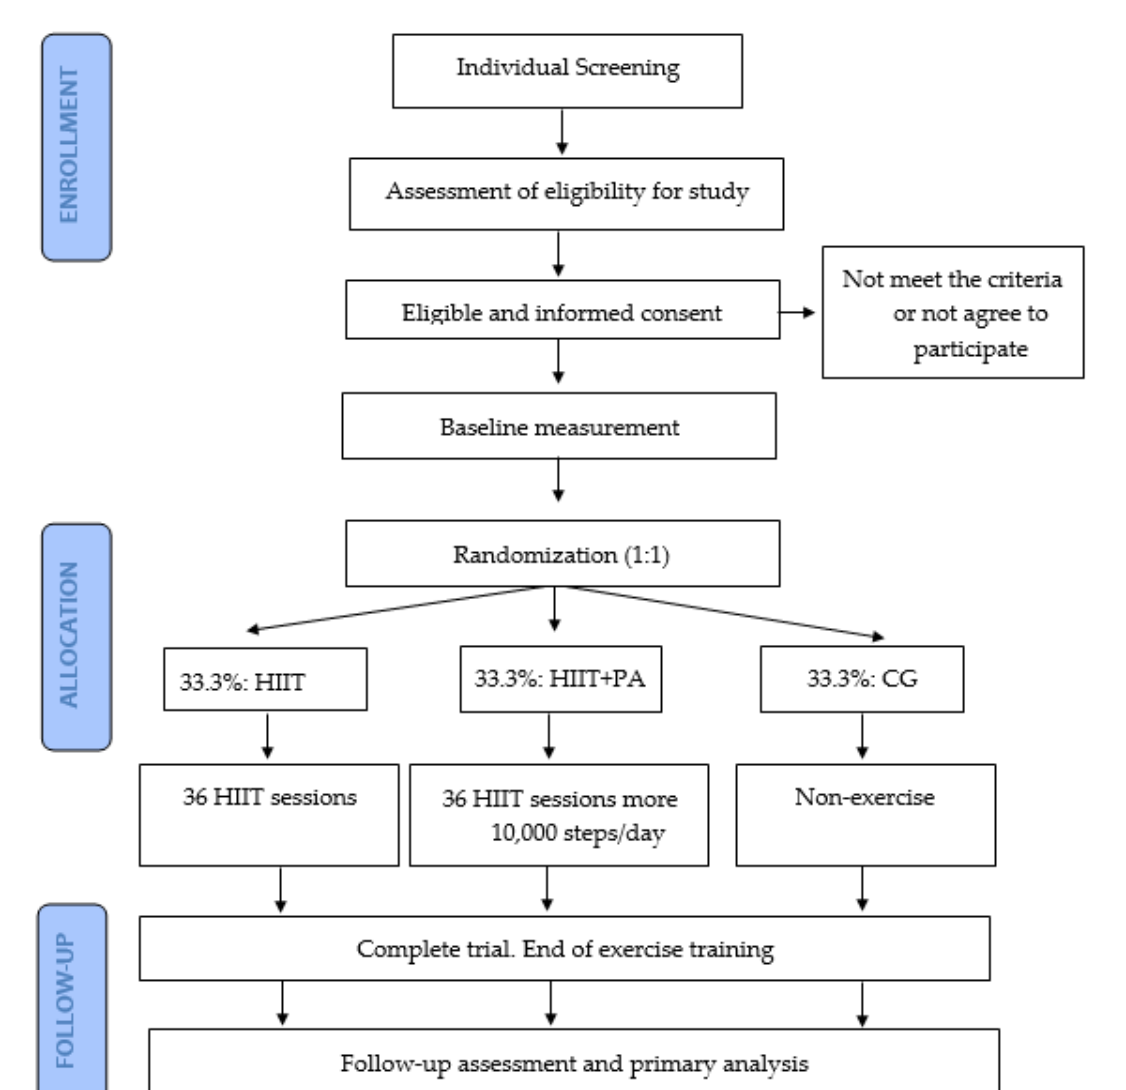
Figure 1. The organizational and participant fl ow diagram.